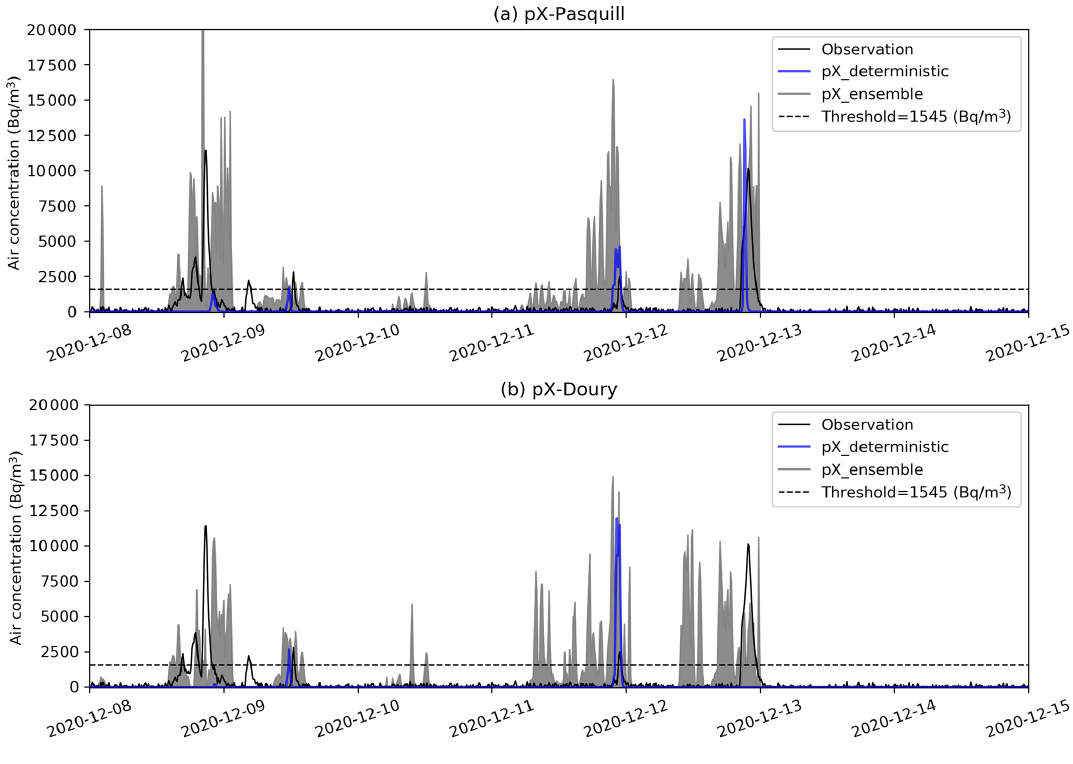
Figure 8. The same as in Fig. 7, but at the LRC station. Table 4. The five observed peaks of 85 Kr at the LRC station (Fig. 9) from 8 to 12 December 2020, and the simulated peaks in the three selected members (in Bqm − 3 ), for pX–Pasquill